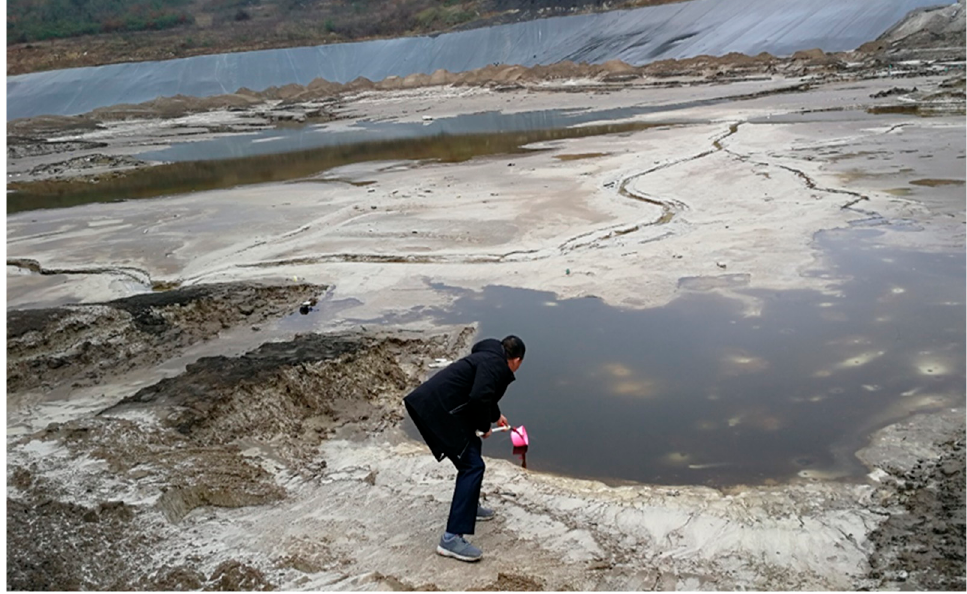
Figure 2. Picture of the sampling of naturally accumulated water from field FGD gypsum dumps (water sample #2).